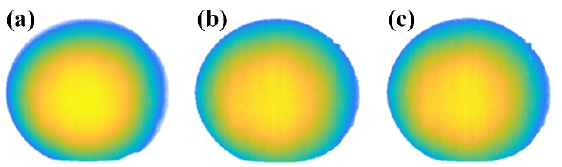
Figure 10. Three-dimensional reconstruction of the standard ball; ( a ) 20-step phase-shifting method. ( b ) The proposed method. ( c ) Method in Ref. [32]. Table 2. Root-mean-square errors (RMSE) between nGL and the proposed method.